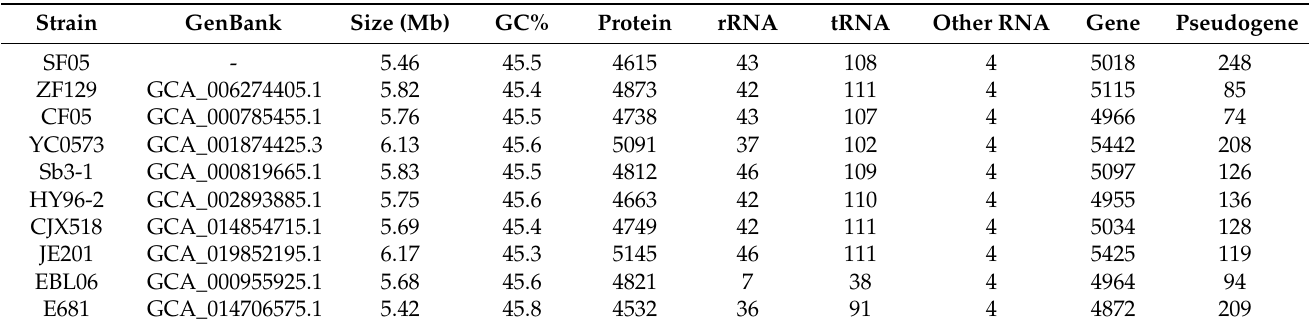
Table 4. Genome information of P. polymyxa was analyzed in this